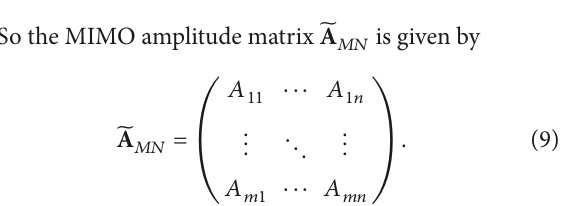
Figure 13: PDP at 85